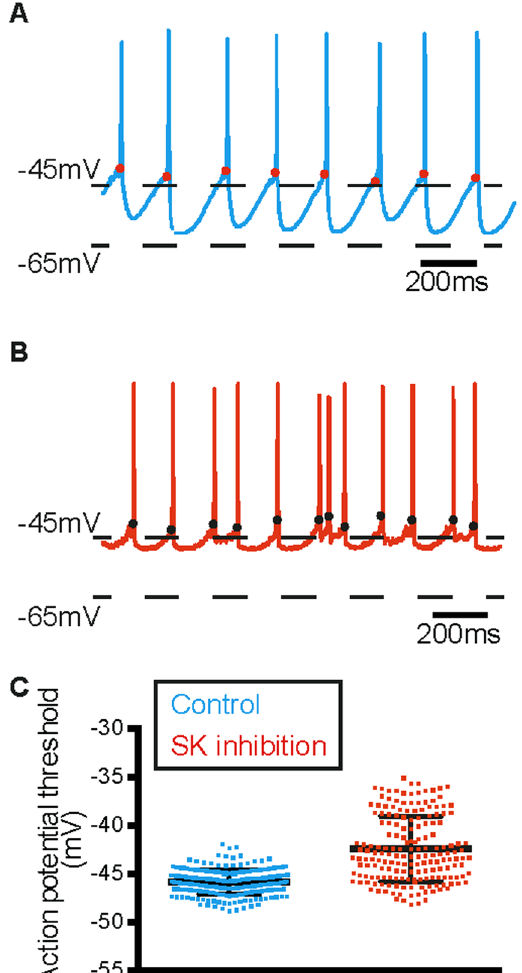
Figure 6. Action potential threshold depolarises and becomes more variable with simulated SK channel inhibition. ( A , B ) When SK channels were inhibited in the model, action potential threshold depolarised and became more variable ( B ) compared to control ( A ). The red and black dots indicate spike threshold. ( C ) Quantification of depolarisation in spike threshold as an effect of SK channel block in the model. Error bars represent mean ± S.E.M, not visible due to small